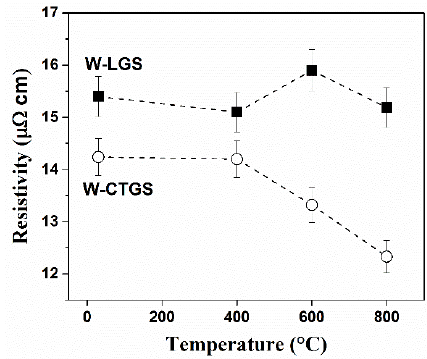
Figure 1. Electrical resistivity upon annealing 100 nm W films on LGS and CTGS at 400 °C, 600 °C, and 800 °C for 12 h each under vacuum (a maximum error of < 5 % is considered due to fluctuation in the